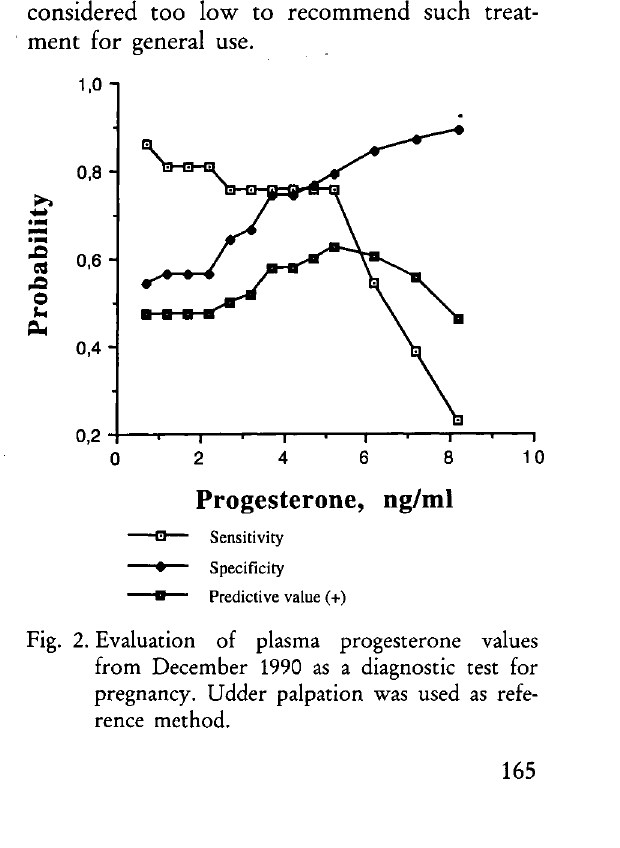
Fig. 2. Evaluation of plasma progesterone values from December 1990 as a diagnostic test for pregnancy. Udder palpation was used as refe rence